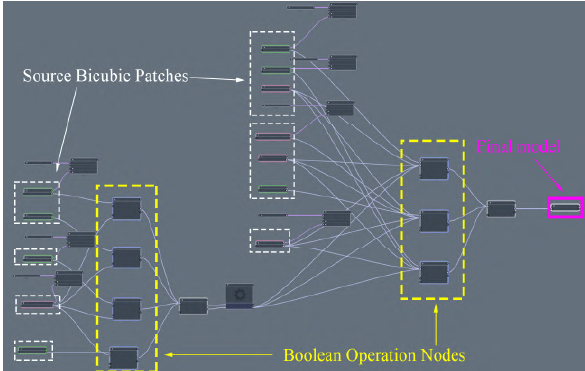
Figure 17. Schematic